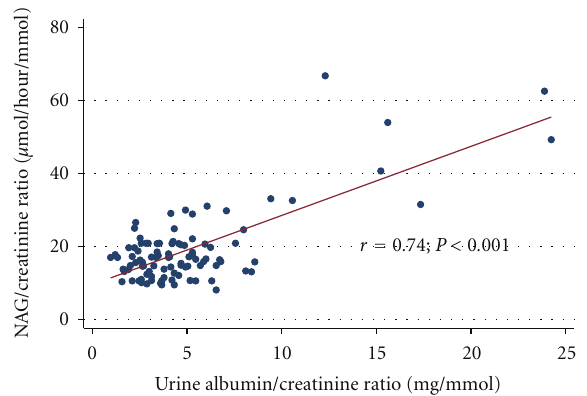
Figure 2: Linear relationship of urinary NAG/creatinine ratio to urinary albumin/creatinine